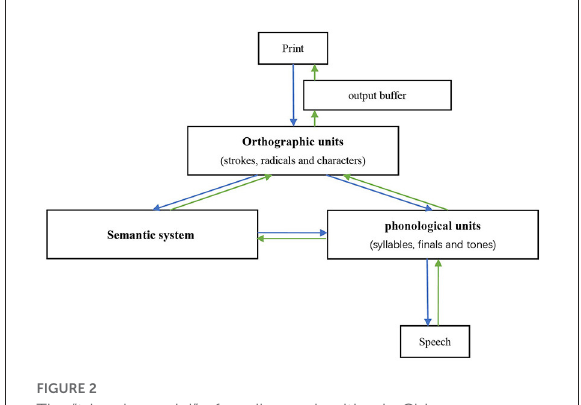
FIGURE2 The “triangle model” of reading and writing in